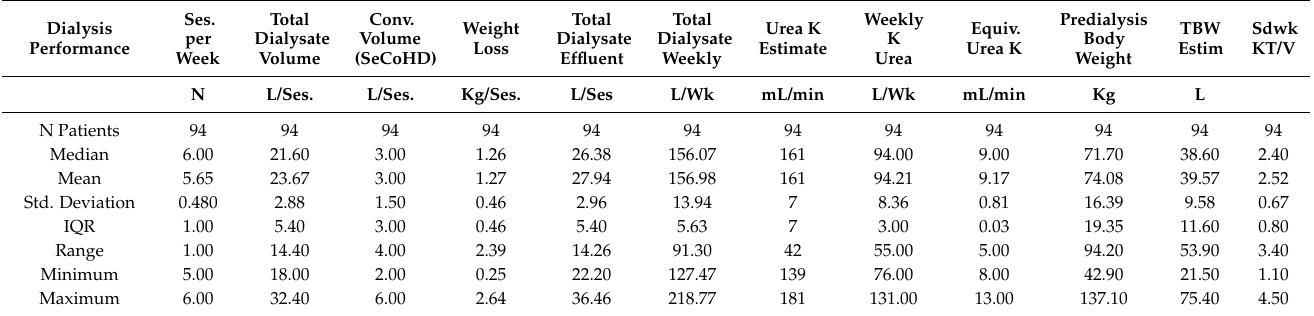
Table 3. Operating conditions and clinical performances during the